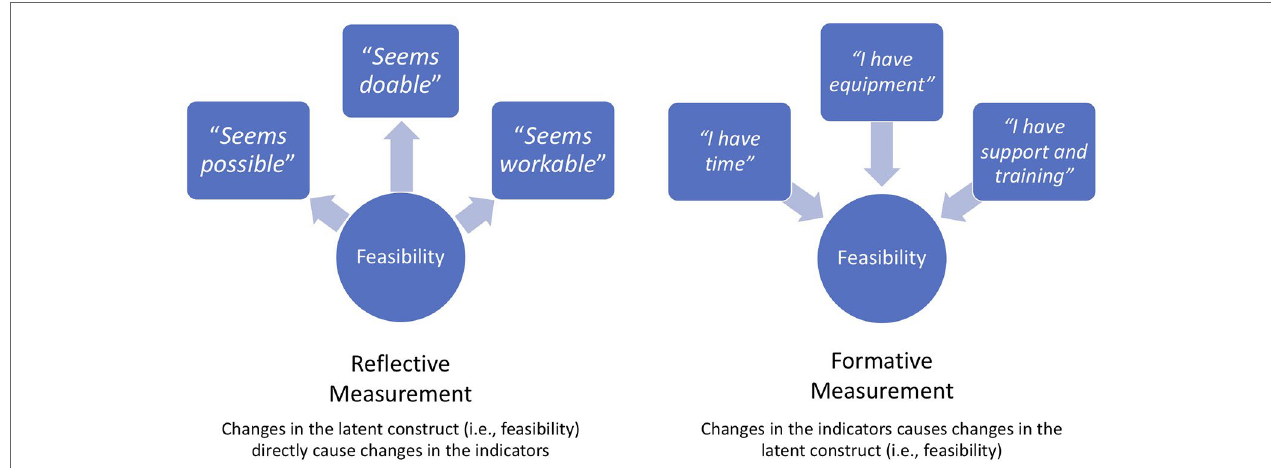
FIgUrE 1 | Distinction between reflective and formative measurement